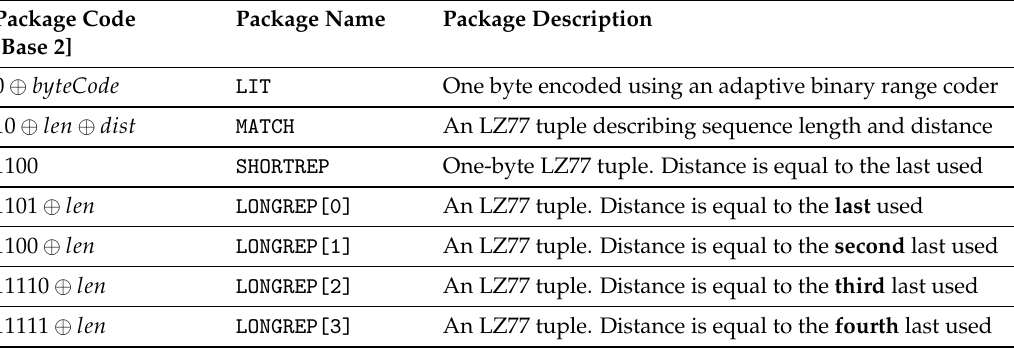
Table 1. Sliding window encoding output packages, based on source code [36]. The symbol represents concatenation of binary